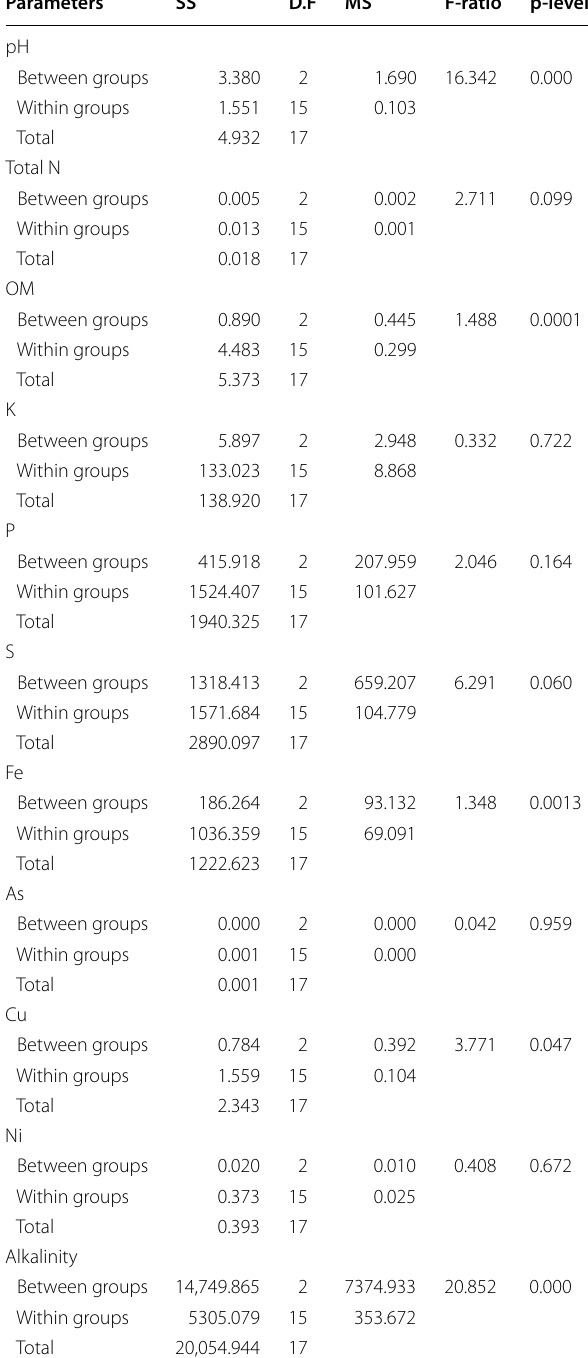
unpolluted soil samples and Fig. 7 showing the same result graphically. The criteria of ranking the pollution level are taken from the standard of RSRDIB. Here,